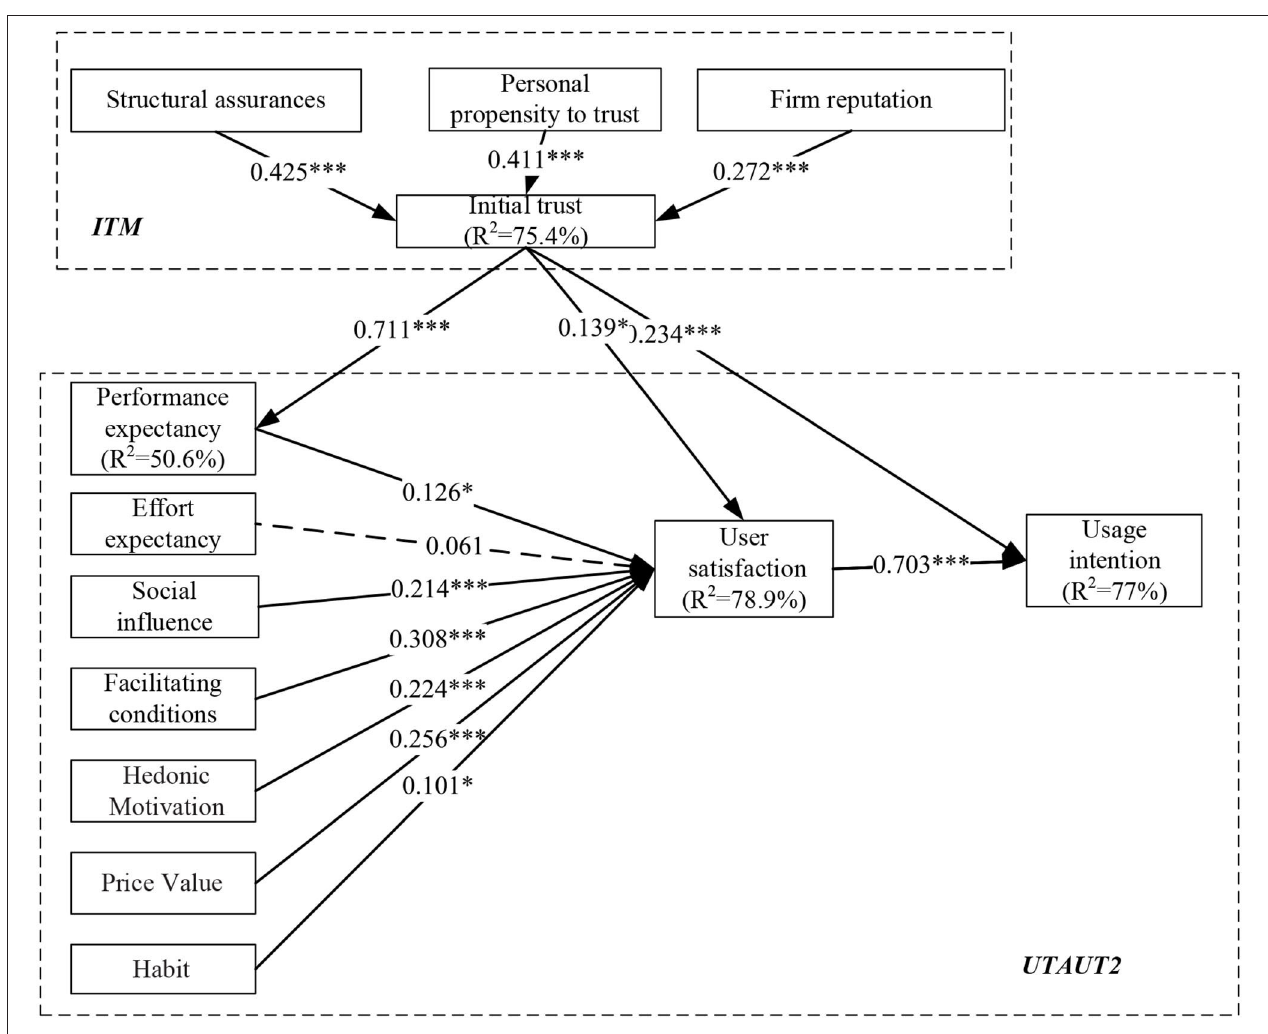
FIGURE 3 | Path analysis of the model (Korea users). * p < 0.05; ** p < 0.01; *** p < 0.001; ns,